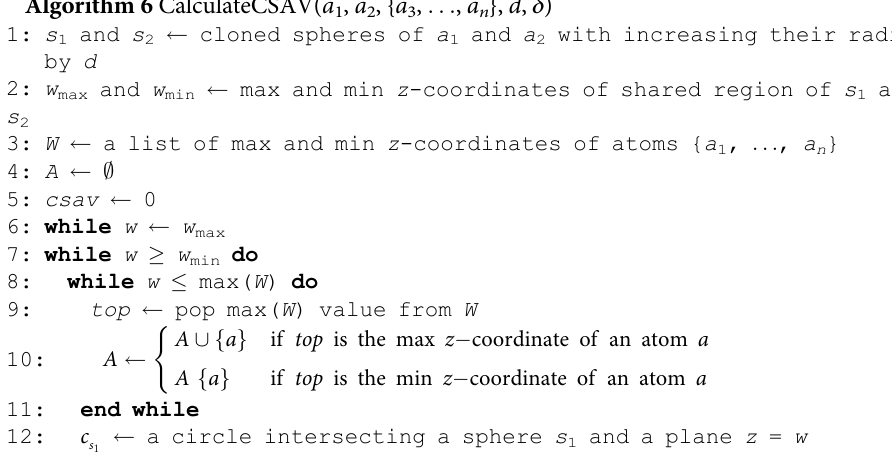
Algorithm 6 CalculateCSAV( a